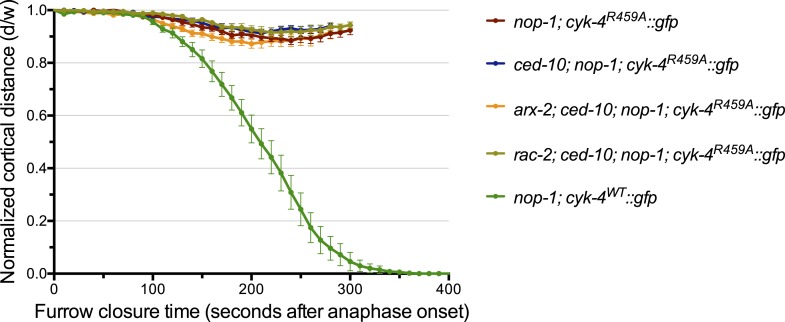
Depletion of neither ARX-2 nor RAC-2 modulates the cytokinesis defect in nop-1; ced-10; cyk-4R459A embryos.The kinetics of furrow ingression in cyk-4R459A::gfp; nop-1(it142); ced-10(n1993) embryos depleted of either ARX-2 or RAC-2. Results are quantified as described in Figure 1G. The kinetics of furrow ingression in nop-1(it142); cyk-4WT::gfp, cyk-4R459A::gfp; nop-1(it142), and cyk-4R459A::gfp; nop-1(it142); ced-10(n1993) embryos from Figures 1G, 4C are shown for comparison.